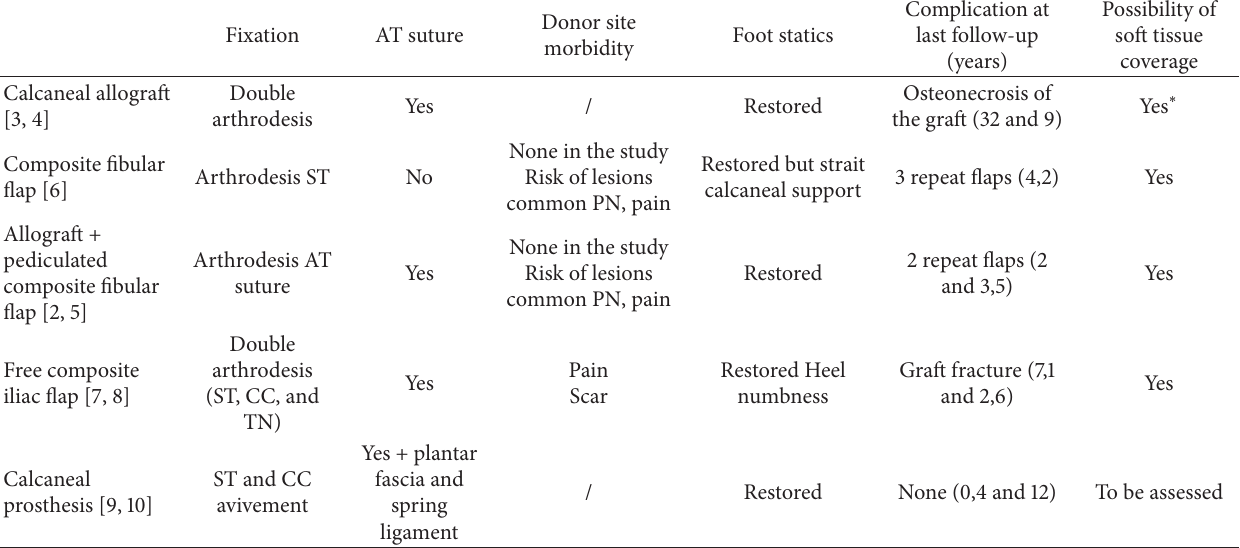
Table 2: Comparison of different reconstruction techniques following